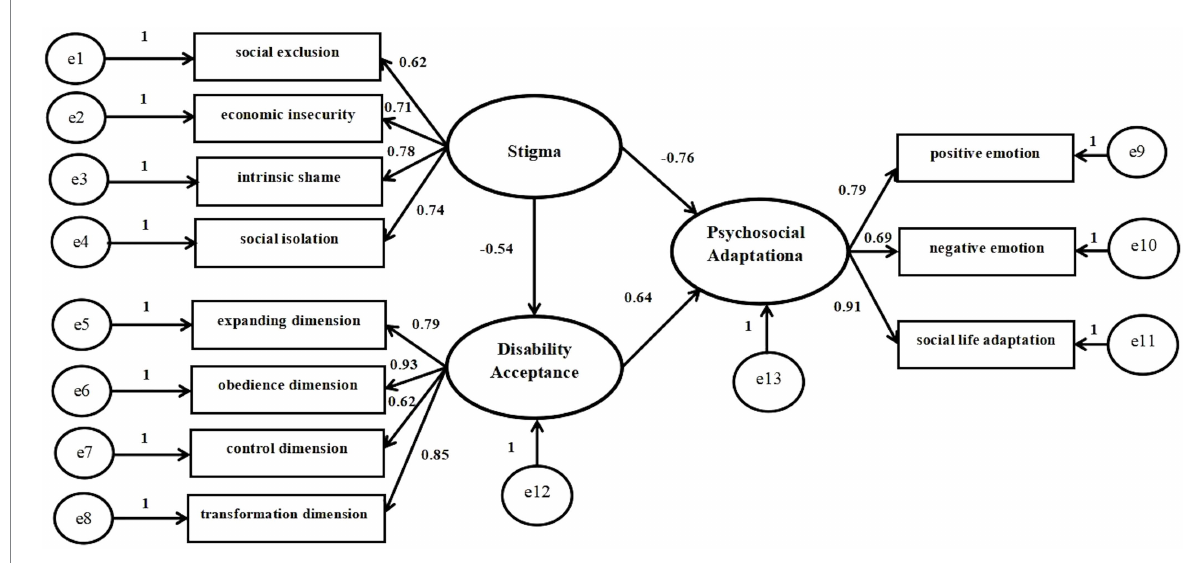
FIGURE 2 Structural equation model of stigma, disability acceptance and psychosocial adaptation in patients with stoma. indicators are up to standard, which proves that the model is well adapted. At the same time, the three assumptions were supported in the model. It was found that stigma has a significant direct effect on psychosocial adaptation ( β = 0.542, p< 0.01, 95% confidence interval (95%CI) [ − 0.615, − 0.273]. Stigma has a significant direct effect on disability acceptance; disability acceptance has a significant direct effect on psychosocial adaptation ( β = − 0.342, p< 0.01, 95% confidence interval (95%CI) [ − 0.575, − 0.181]; β = 0.465, p< 0.01, 95%CI [0.241, 0.735]).